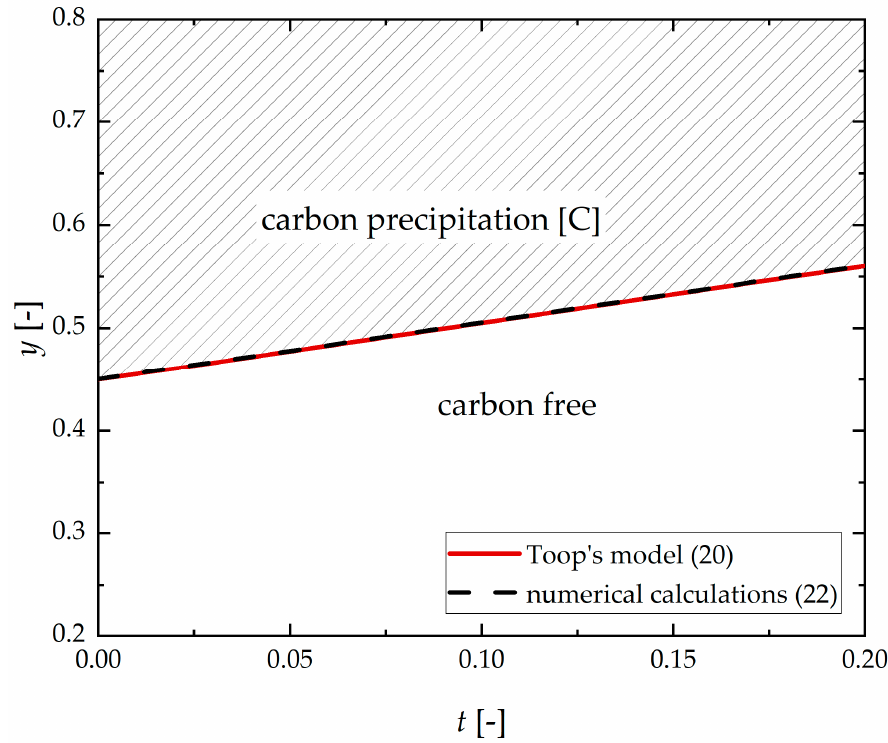
Figure 3. Range of carbon precipitation [C] = f ( t , y ) for T = 1000 K in system (CH 4 /H 2 )–H 2 O according to the numerical calculations and Toop’s model.